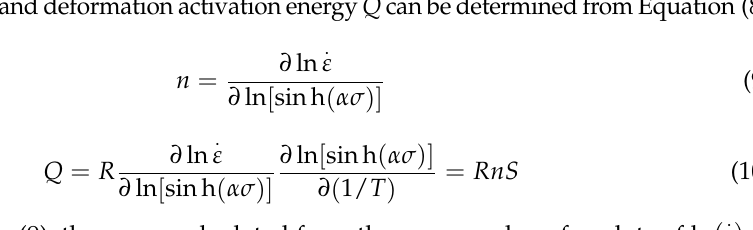
Figure 3. The relationship between peak stress and strain rate: ( a ) ln σ (cid:3017) − ln( ε ) (cid:4662) and ( b ) σ (cid:3017) − ln ε (cid:4662) .